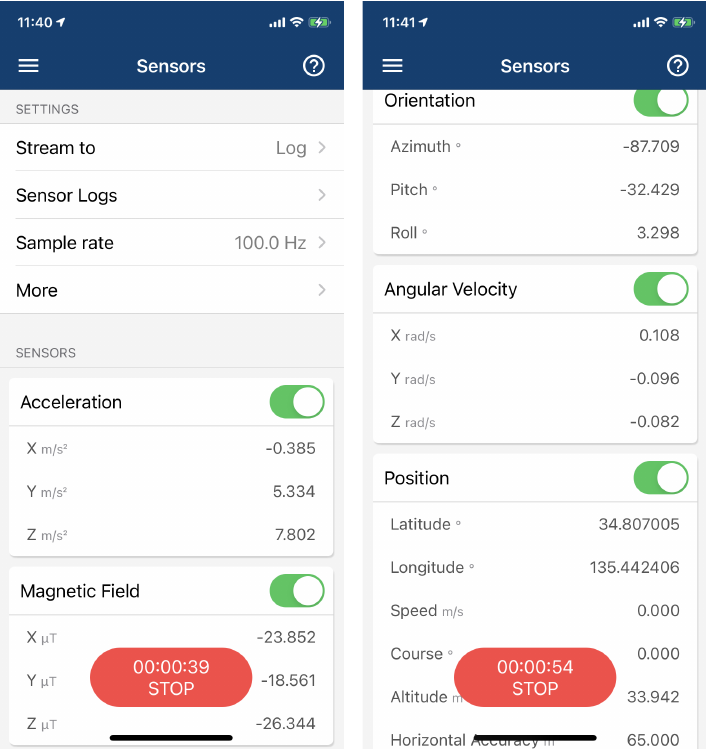
Figure 1. Smartphone “Sensors” application